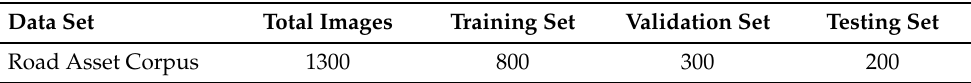
Table 2. Numbers of training, validation, and testing sets. Data Set